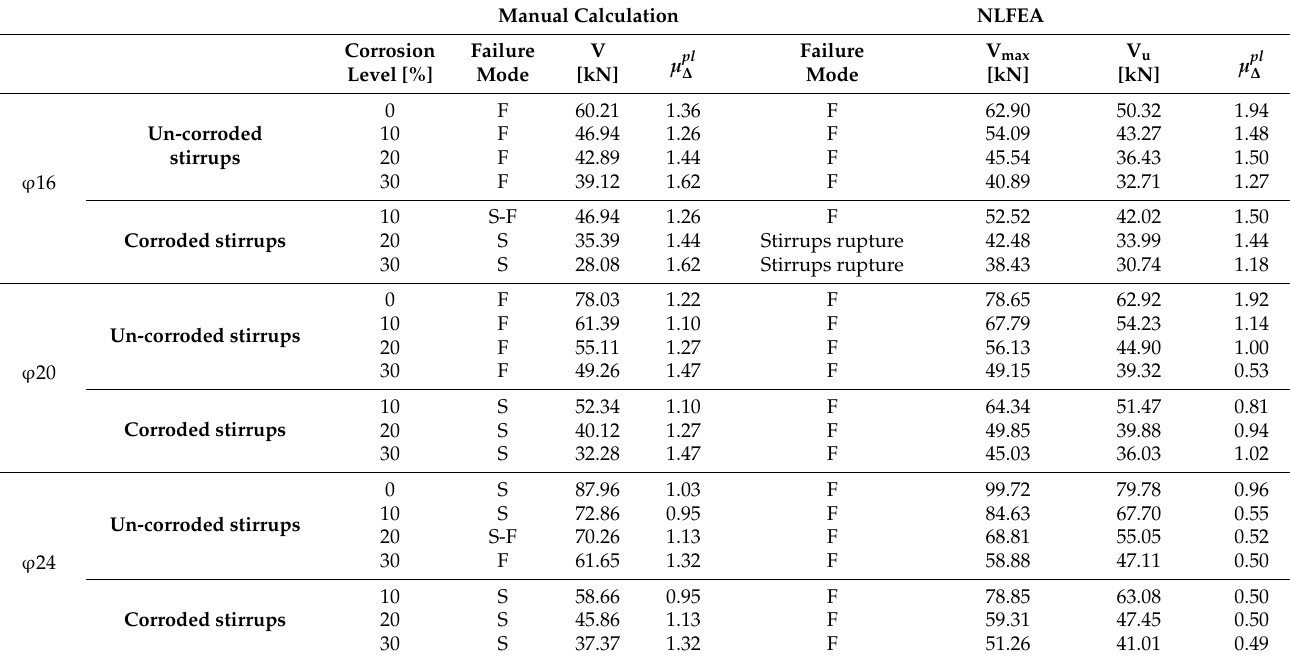
Table 3. Comparison between failure modes and ductility factor obtained from analytical calculations and NLFEA.